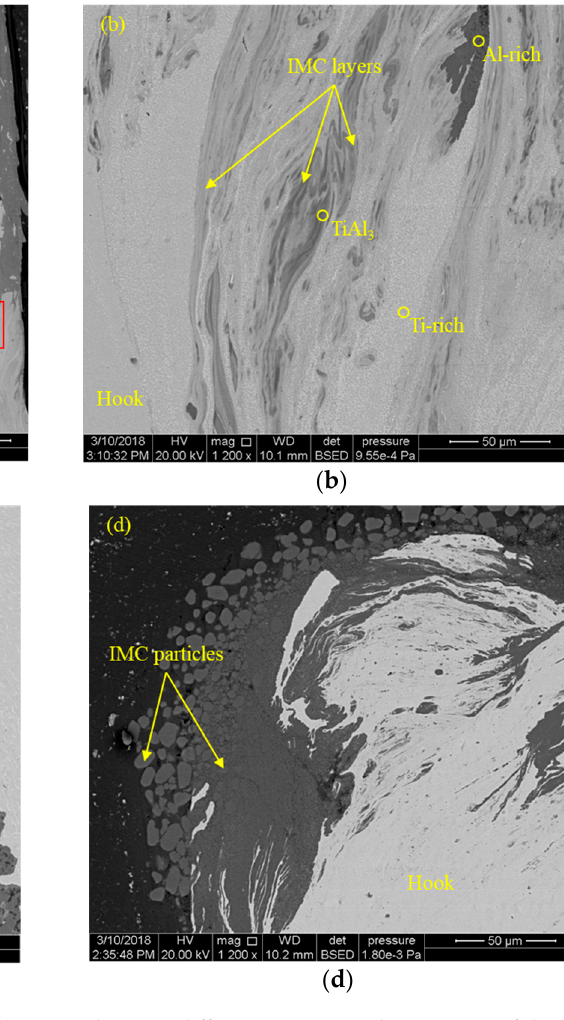
Figure 4. Scanning electron microscopy (SEM) image showing different regions in the stir zone of the FSSW-B joint; ( a ) high magnification view of the hook zone (region A marked in Figure 3a); ( b ) region S1 indicating the interlocking; ( c ) region S2 indicating the tip of the hook; and ( d ) magnified view of region S3. IMC—intermetallic compound.